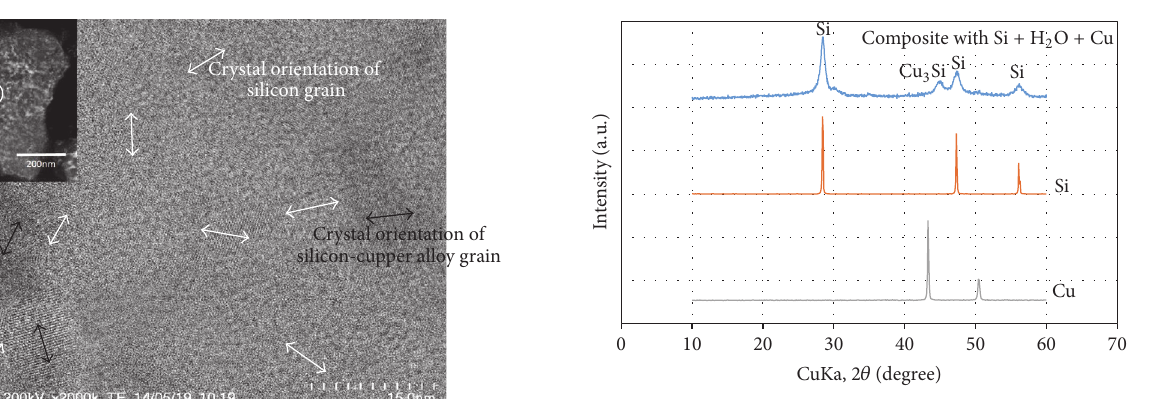
Figure 5: High-resolution STEM image of the composite (in the area indicated by a white circle in the inset) showing the presence of Si and Si–Cu alloy materials.